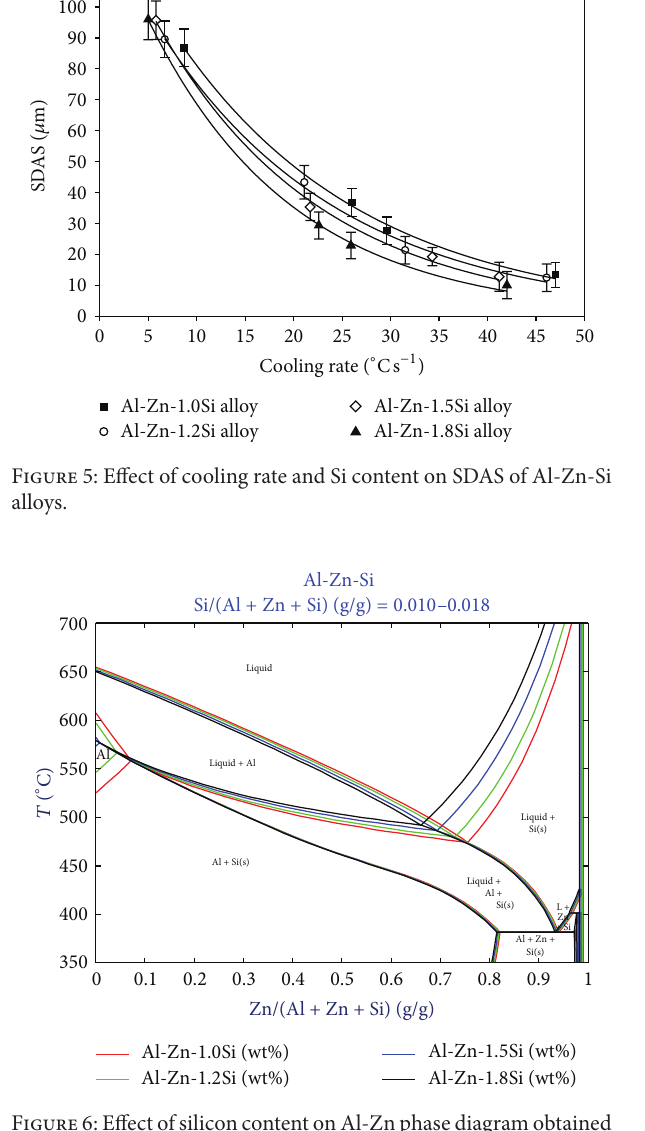
Figure 6: Effect of silicon content on Al-Zn phase diagram obtained from FactSage Software.